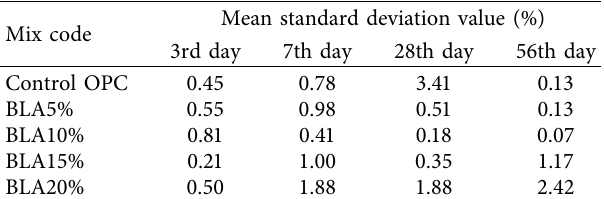
Table 11: Mean standard deviation from the compressive strength average value.